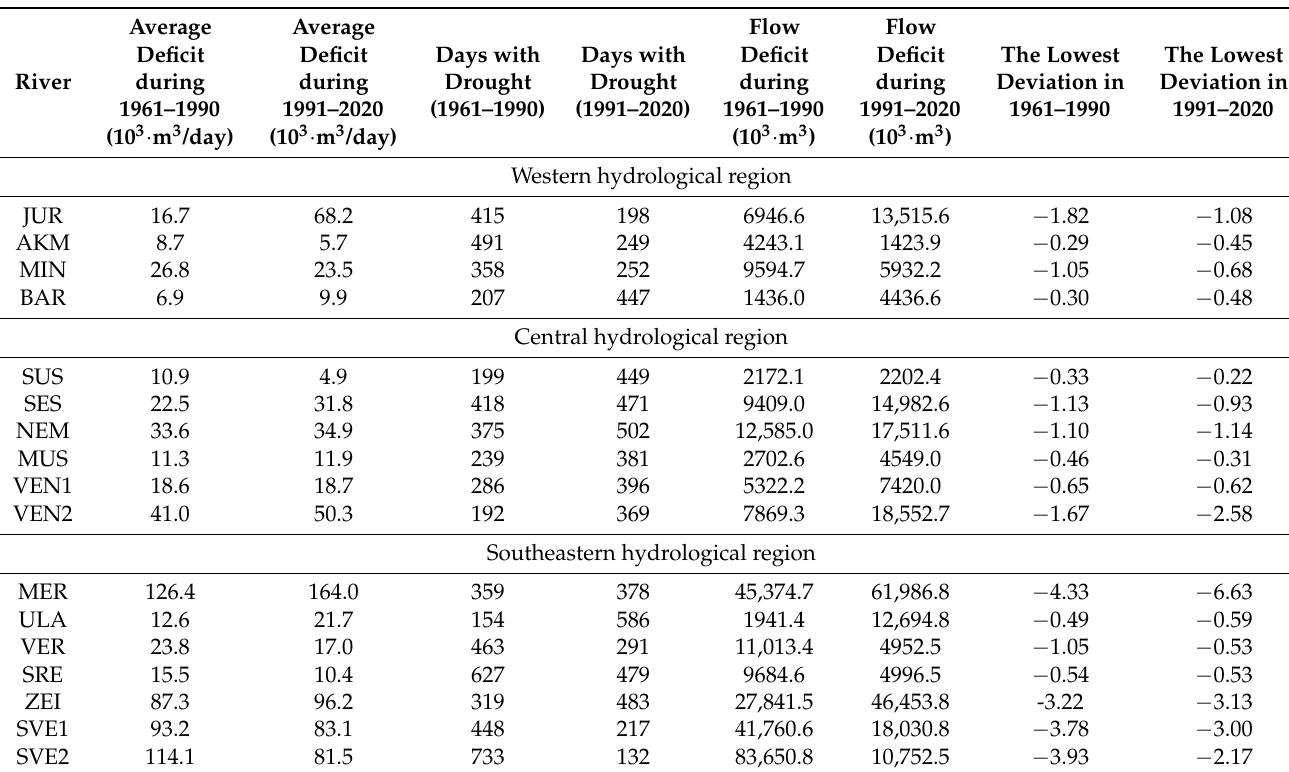
Table 5. Changes for